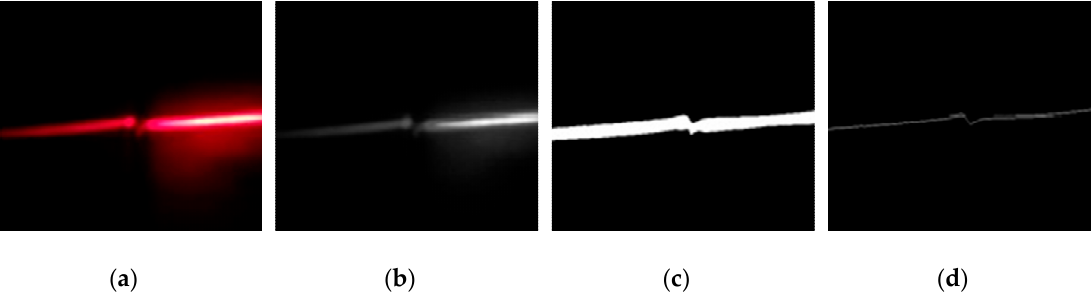
Figure3. Blockdiagramsoftheinspectiontasks: ( a )pre-weldinginspection; ( b )post-weldinginspection. Figure 3. Block diagrams of the inspection tasks: ( a ) pre-welding inspection; ( b ) post-welding inspection.